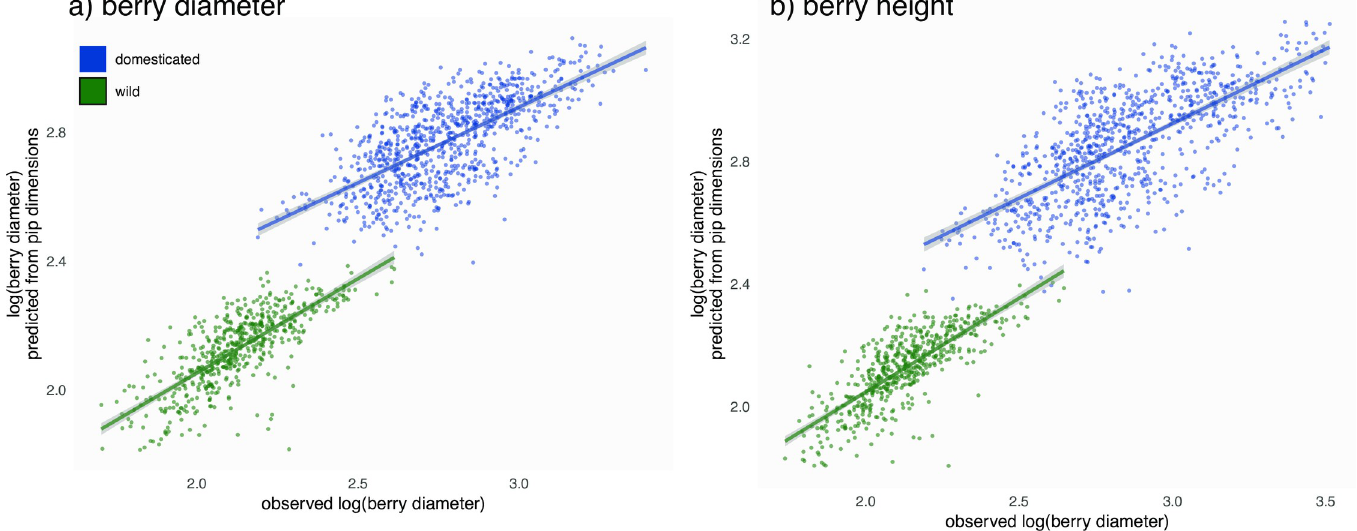
Fig 8. Regressions for berry dimensions from pip dimensions, obtained on modern material: Predicted versus actual (logged) berry dimensions at the domestication status level (all accessions). Columns are for berry diameter and height, respectively.